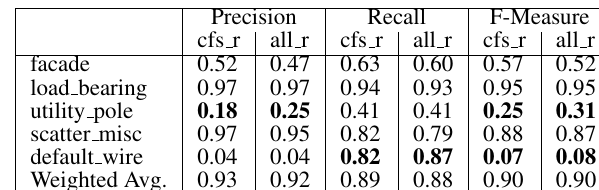
Figure 11. F1 - Ball-shaped neighbourhood, class wise performance of the SVM